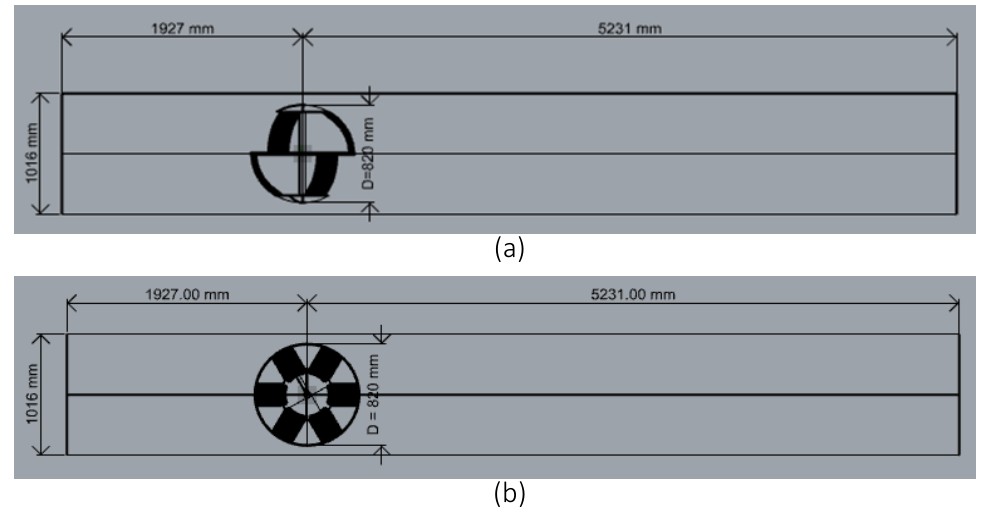
Figure 3. Coordinate system and boundary conditions.